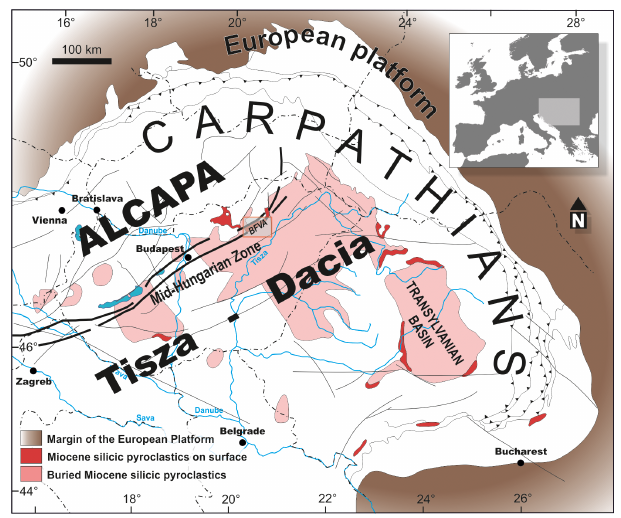
Figure 1. Distribution of Miocene felsic pyroclastics within the Pannonian Basin (Central Europe). BFVA – Bükk Foreland Vol- canic Area. The map was modified after Pécskay et al. (2006). The occurrence of buried pyroclastics is based on drillings. The main structural lines (solid line) and the main faults (black triangles) are